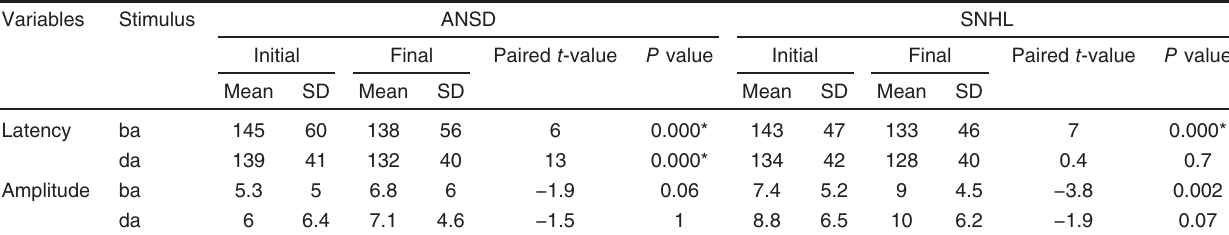
Table 5 Paired t -test for P1 measures in the auditory neuropathy spectrum disorder and sensorineural hearing loss groups between the initial and after 6 months of evaluation